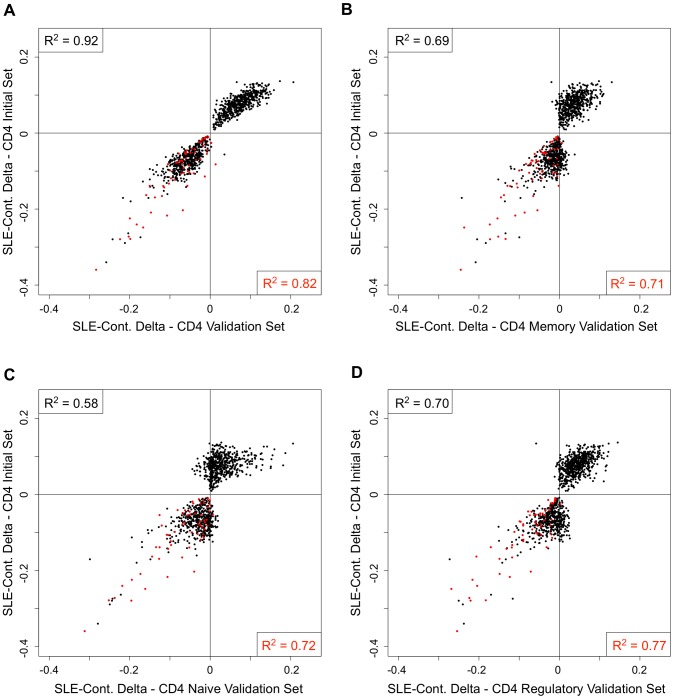
Comparison of the SLE-control methylation differences in sorted T-cell populations.Each scatter plot represents 1,031 CpGs that had p<1×10−8 in CD4+ T-cells in our SLE-control association tests. The Y-axis for all plots is the mean SLE-control methylation delta at these CpGs in the initial cohort. The X-axis for each plot is the mean SLE-control methylation delta at the same CpGs in our validation cohort, using (A) total CD4+, (B) CD4+Memory, (C) CD4+Naïve, or (D) CD4+Regulatory cells. The red dots represent CpGs near IFN-regulated genes and the squared correlation coefficients (R2) represent the values for all plotted CpGs (upper left) or IFN CpGs only (lower right).